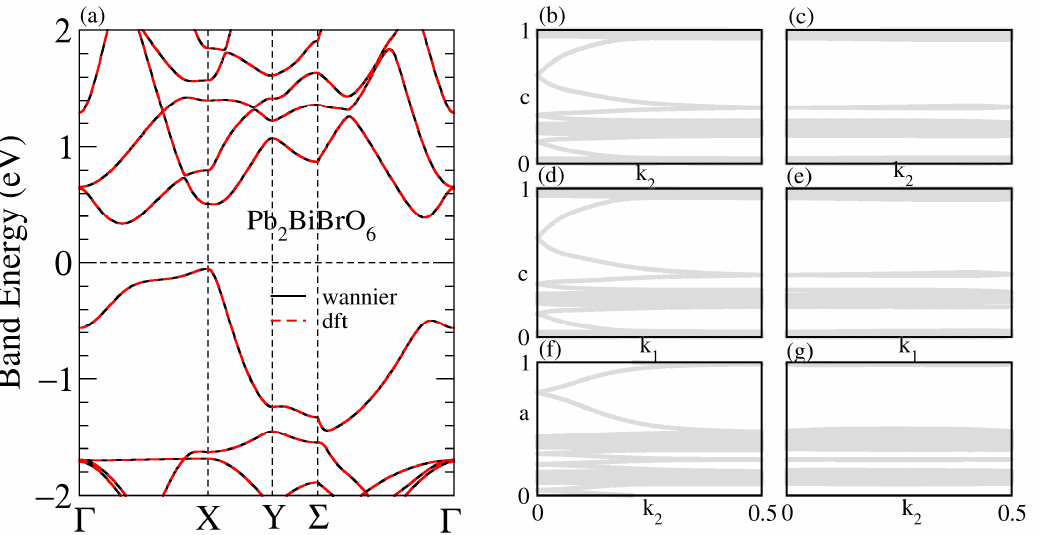
Figure 4. Scalar relativistic, ( a , b ), and fully relativistic, ( c , d ), atom and orbital decomposed densities of states of the Pb 2 BiBrO 6 and Pb 2 SeTeO 6 double perovskites. projected onto the s -(red) and p x -(blue), p y -(green) and p z -(orange) orbitals. Note that only BiBr(SeTe) s - and p -orbitals are projected. The Fermi energy is shifted to zero as a reference.